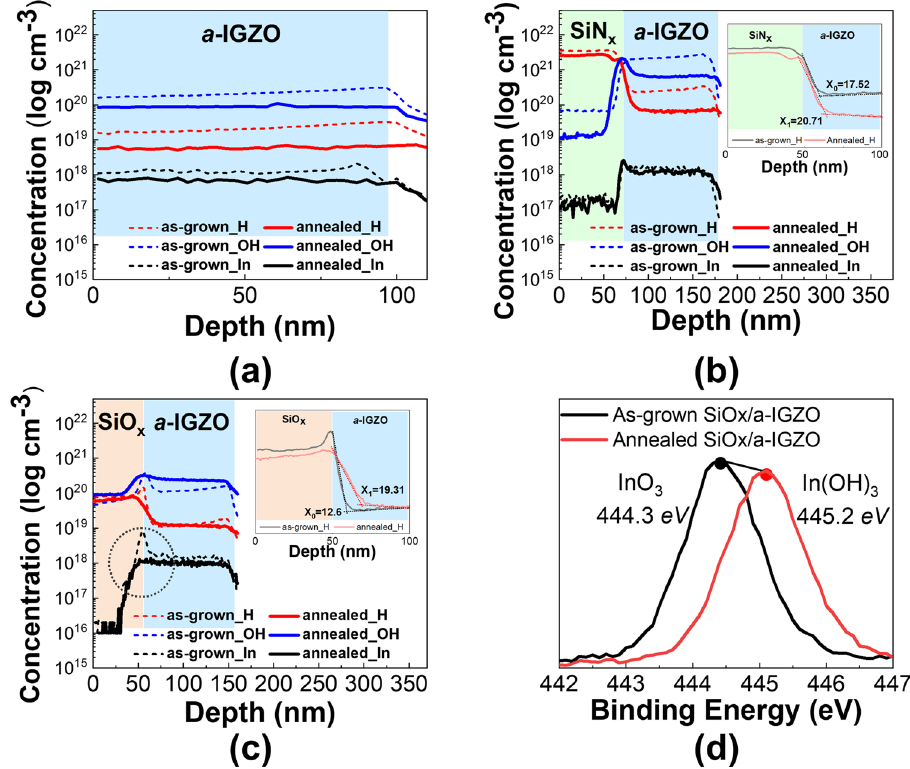
Figure 3. SIMS depth profiles of hydrogen, hydroxide (OH), and indium (In) in as-grown and annealed a -IGZO films; ( a ) conventional a -IGZO film, ( b ) a -IGZO film covered with SiN x , ( c ) a -IGZO film covered with SiO x , and ( d ) XPS spectra of the In3d intensity in the dashed open circle area shown in ( c ) for as-grown and annealed a -IGZO films covered with SiO x